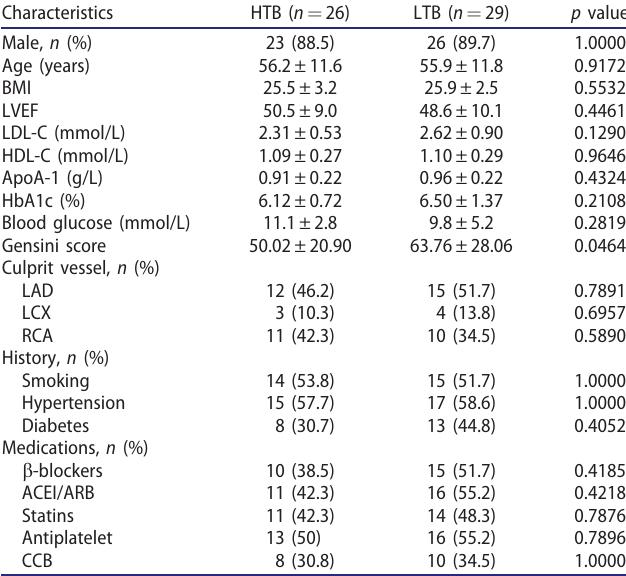
Table 3. Clinical characteristics of patients in the HTB and LTB group. Characteristics